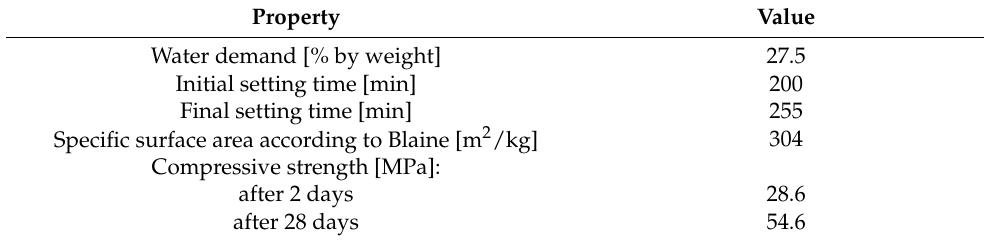
Table 3. Properties of the cement used.